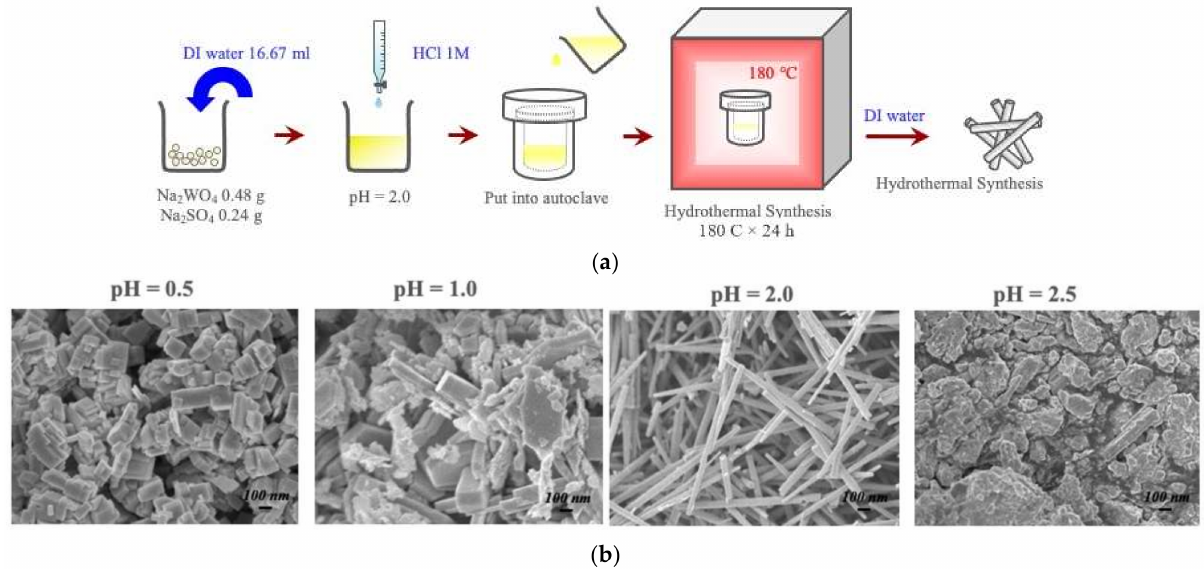
Figure 6. ( a ) Process map for the formation of the metastable hexagonal WO 3 polymorph via hydrothermal treatment [32]; ( b ) SEM images of the microstructure at varying pH [32]. Nanowires are formed at a pH of 2 with lengths of 10